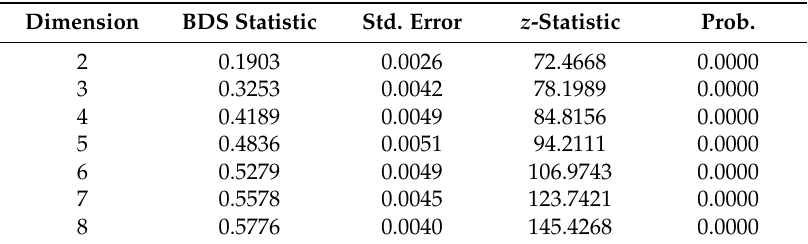
Table 3. The linearity test of the carbon price sequence of SZA2013.